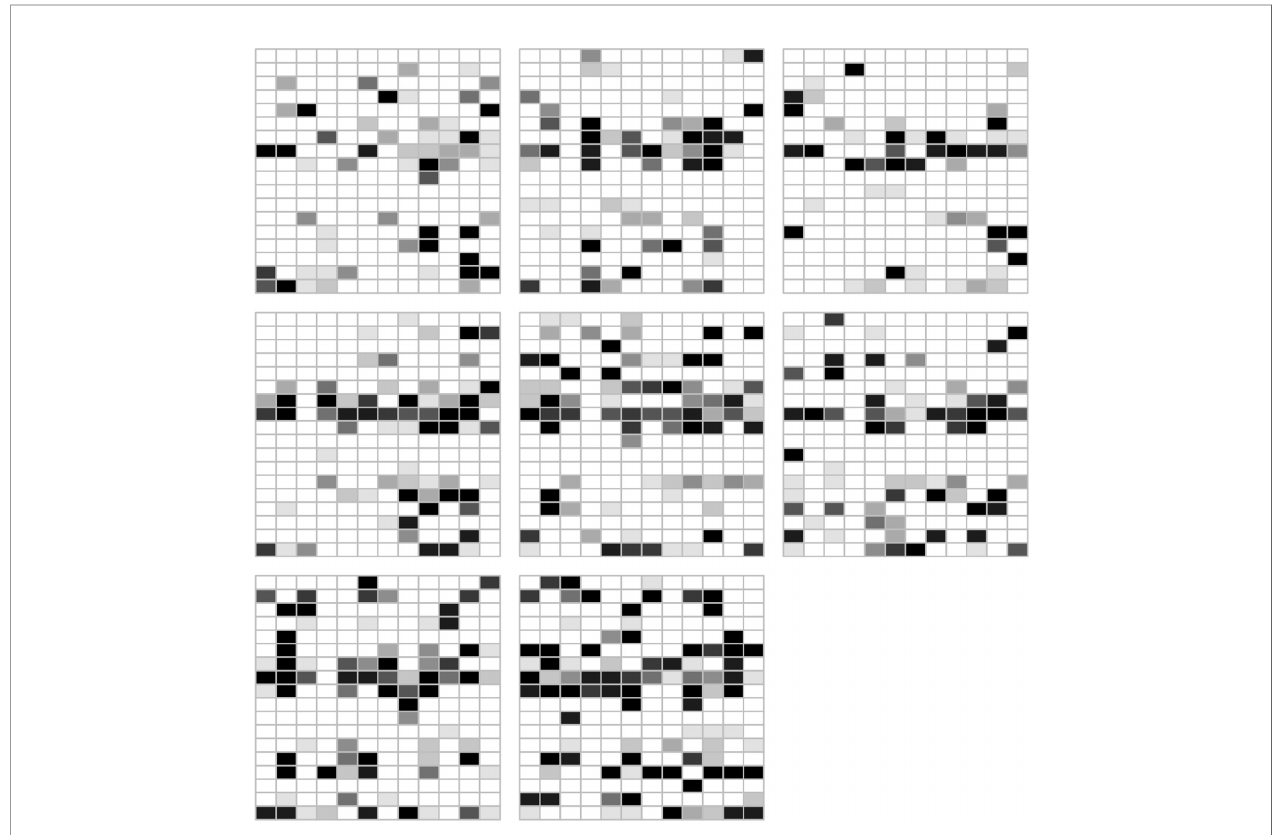
FIGURE 5 | For each ( y , z ) slice with a fi xed x coordinate these heatmaps show the mutant fraction in the 12 × 18 samples for the fi rst maker in the Leydig cell tumor. To reconstruct the 3-D plot, the slices would have to be stacked. Spots in neighboring heatmaps at the same site are direct neighbors of each other in the direction of the x -axis.